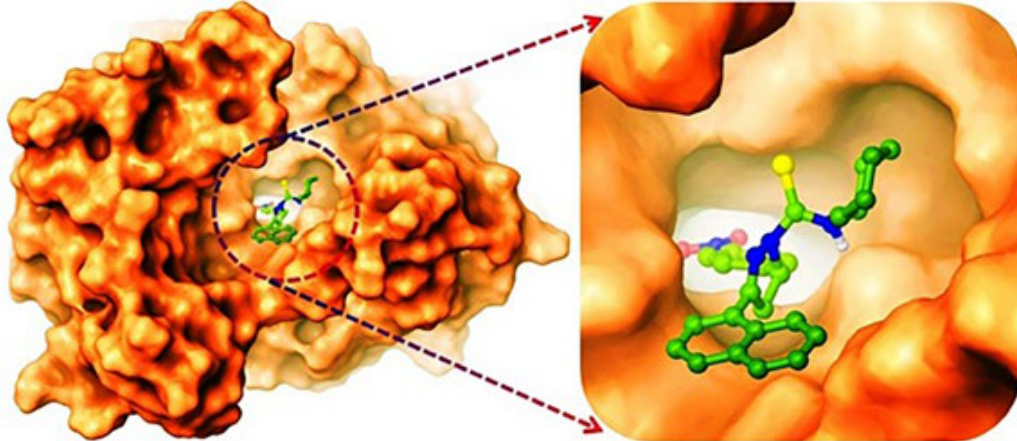
FIGURE 4 - Surface view of compound 4e. The protein is depicted in the surface view and ligand 4e as ball and stick in the binding pocket of hBCATc